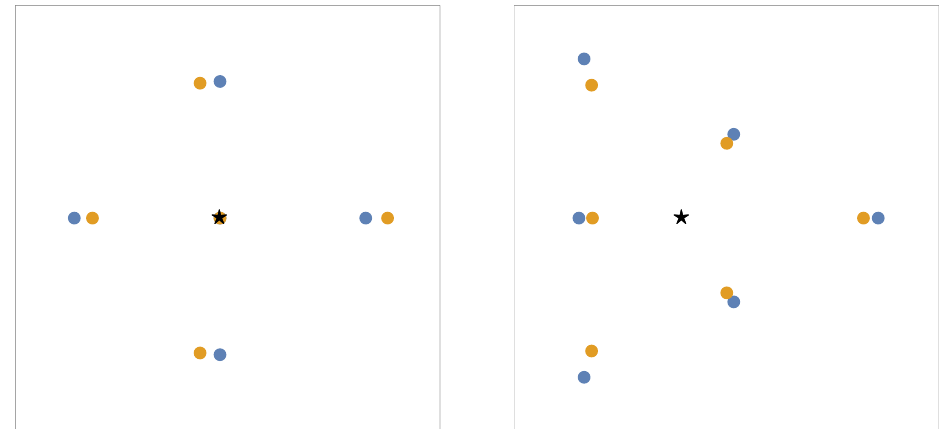
Figure 4 . On the left, the case of the non-degenerate self-conjugate partition (3 , 1 , 1) of N = 5 , and on the right the completely degenerate partition (3 , 2 , 1) of N = 6 . In yellow the numerical solution, in blue the perturbative solution according to formula (10.1) for the case (3 , 1 , 1) , and according to formula (10.4) for the case (3 , 2 , 1) . The star is the point z = L